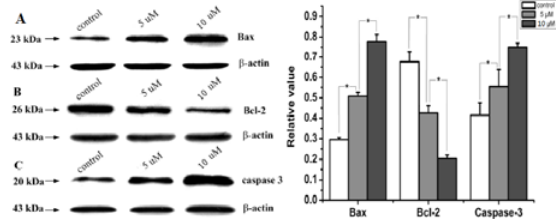
Figure 5. Effects of scutellarein on protein expression levels of Bax, Bcl-2 and Caspase-3 in SAS cells. SAS cells were treated with scutellarein (5, 10 µM) for 96 h. The protein expression levels of Bax, Bcl-2 and Caspase-3 were evaluated by western blotting assay. β -actin was used as an internal control. The expression levels of Bax and Caspase-3 increased as scutellarein concentration rose while the expression levels of Bcl-2 decreased compared to controls. Immunoblots were scanned using a GS-800 densitometer and protein bands from three independent experiments were quantified with Quantity One software (Bio-Rad Laboratories, Hercules, CA). All values were expressed as mean ± SEM. *P<0.05 compared with each